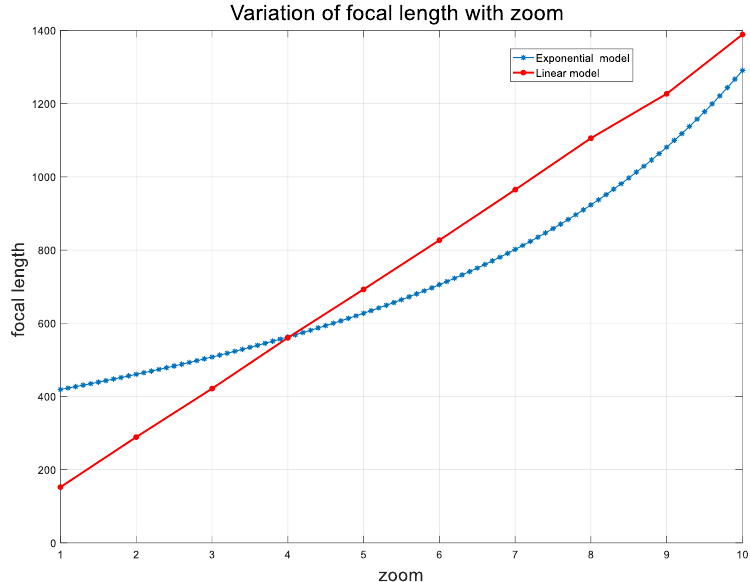
Figure 4. Variation of focal length with zoom of different cameras.